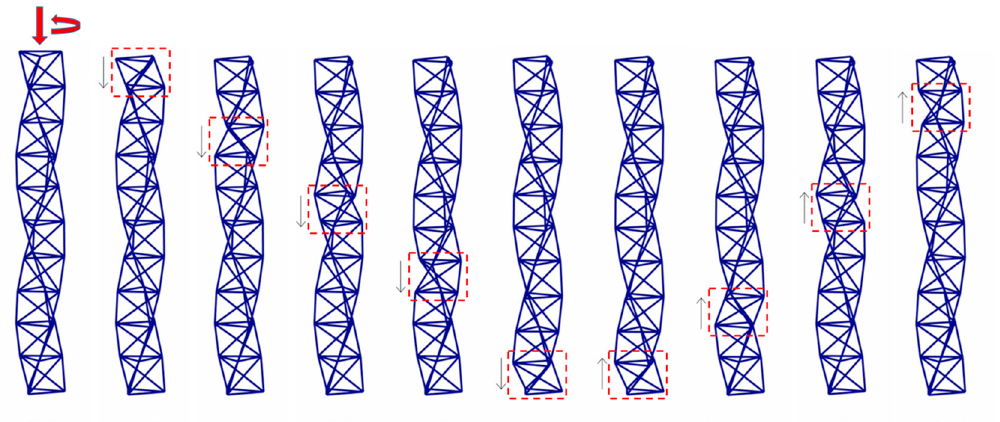
Figure 11. Snapshots extracted from the video of the motion of a column of ten bistable prisms impacted with initial vertical and angular speeds at the top base (see also Video S7 of Supplementary Materials).